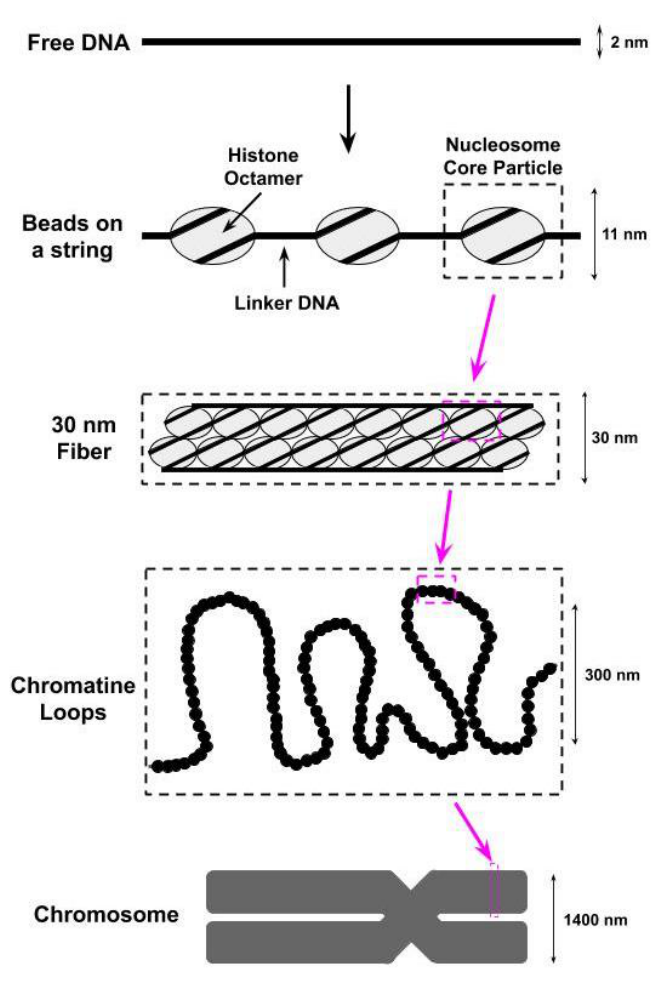
Figure 1. The first level of compacting the genome into chromatin involves wrapping the DNA around octamers of histone proteins to form nucleosomes. We identify in this figure a nucleosome core particle, which consists of an octamer of histone proteins wrapped by ≈ 147 basepairs of DNA. These nucleosome core particles are further wrapped together to form a structure known as a 30 nm fiber due to its physical dimensions. Supercoiling of the 30 nm fibers into chromatine loops then leads to the formation of a